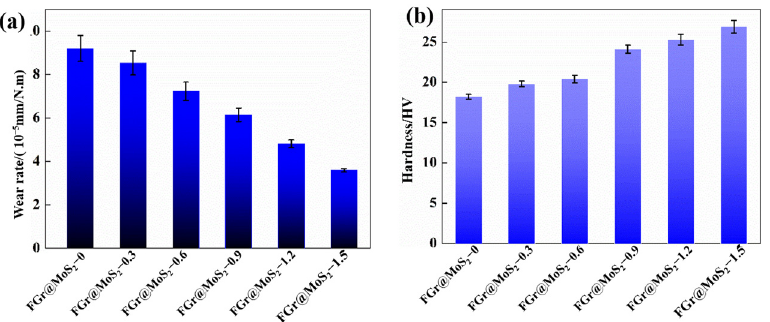
Figure 4. ( a ) Wear rate and ( b ) Vickers hardness of CFRP containing different contents of